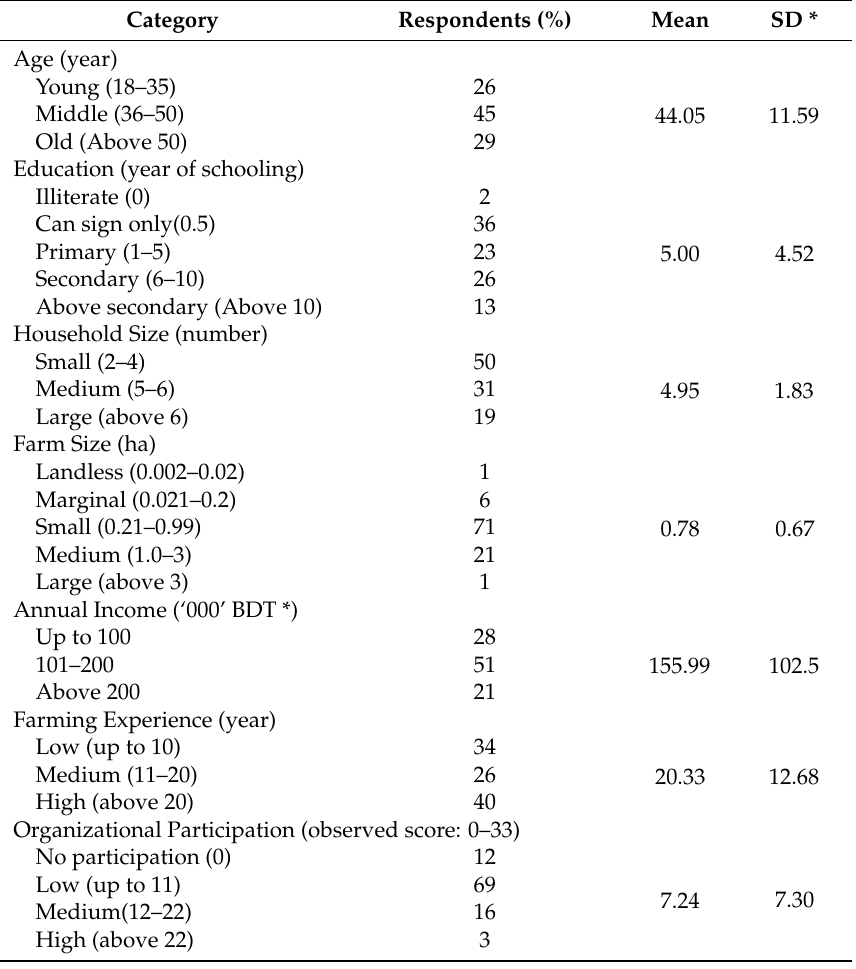
Table 1. Socio-economic characteristics of the respondents ( n =